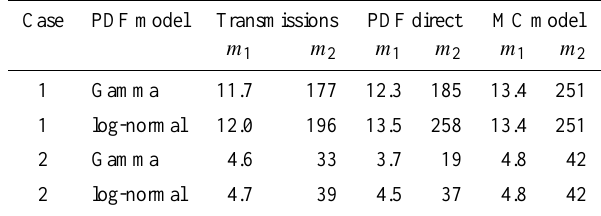
Table 2. Results (moments m 1 / 2 ) of the PPD retrievals for the first two moments using both PDF models for both cases. Also included are the results of the direct fit to the MC PDF, see Fig.